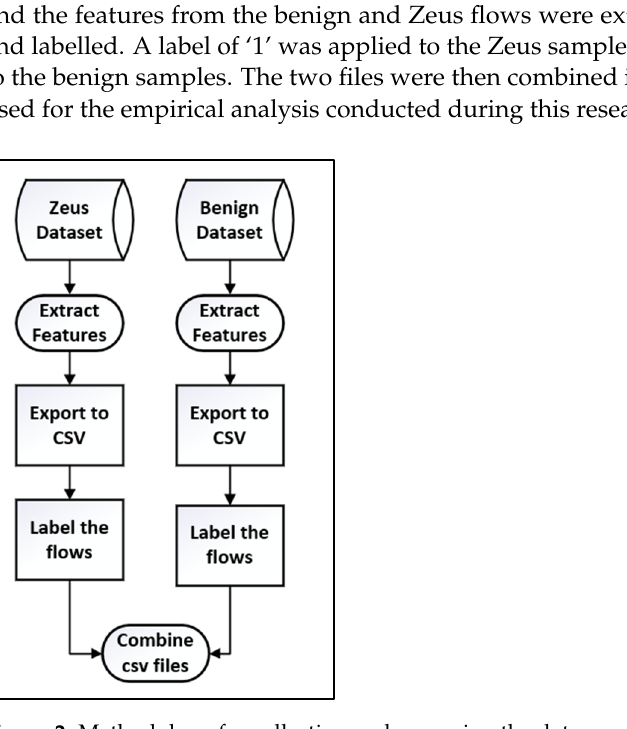
Figure 2. Methodology for collecting and preparing the